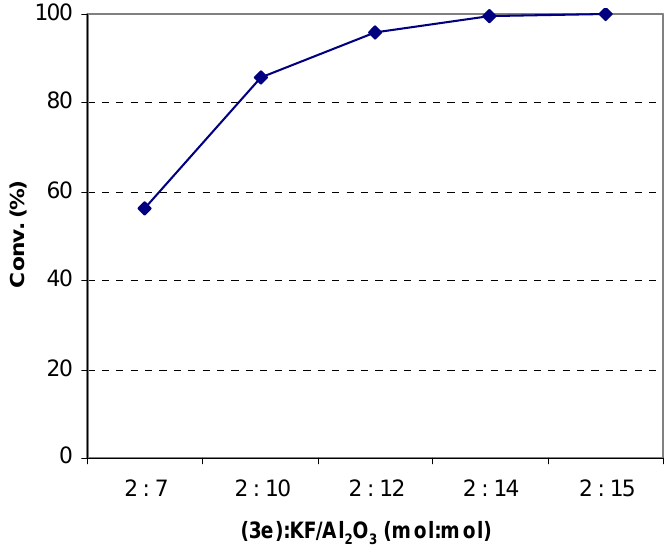
Table 3. Optimization of the hydrolysis of vanillin acetate by KF/Al